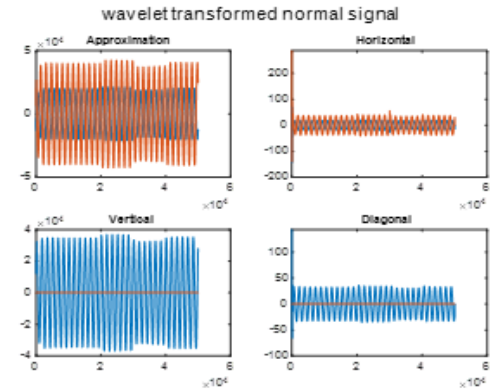
Figure 5. Simulation:line-line fault signal